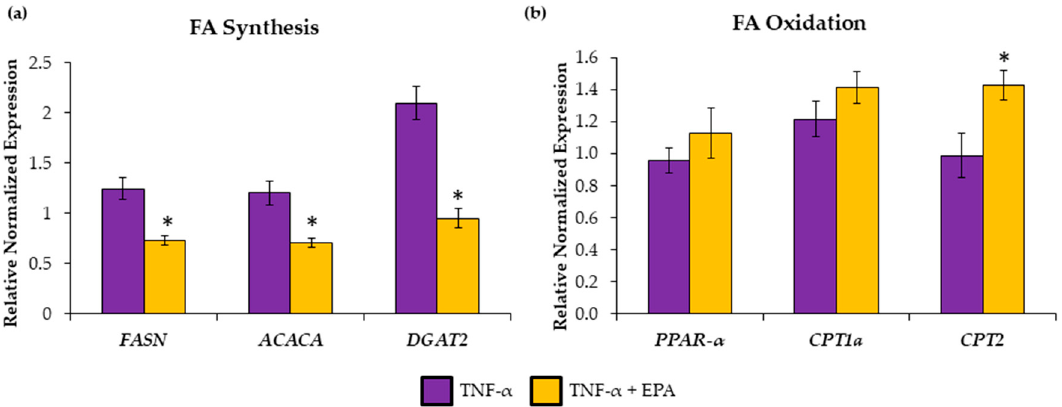
Figure 4. Eicosapentaenoic acid (EPA) supplemented to tumor necrosis factor-alpha (TNF- α )-treated HepG2 cells alters fatty acid (FA) metabolism. Gene expression studies indicate significant ( a ) decreases in markers of FA synthesis: fatty acid synthase ( FASN ),